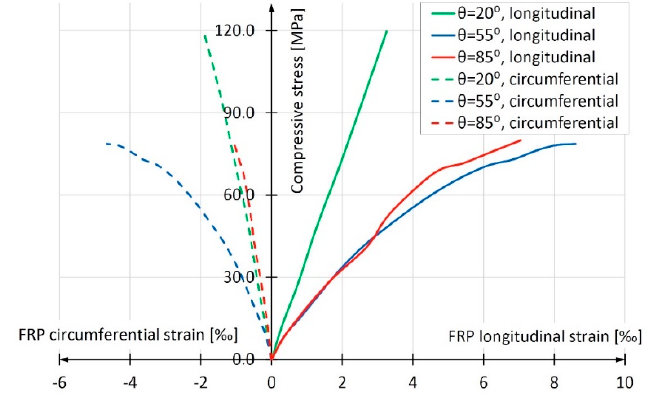
Figure 7. Stress-strain relationship for test elements made of 40-cm-long hollow composite tube.